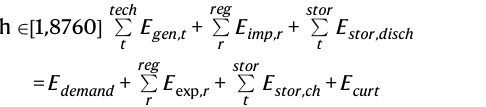
gridssimulatedinthe fi rststep.Theresultsrepresenttheoperationsof